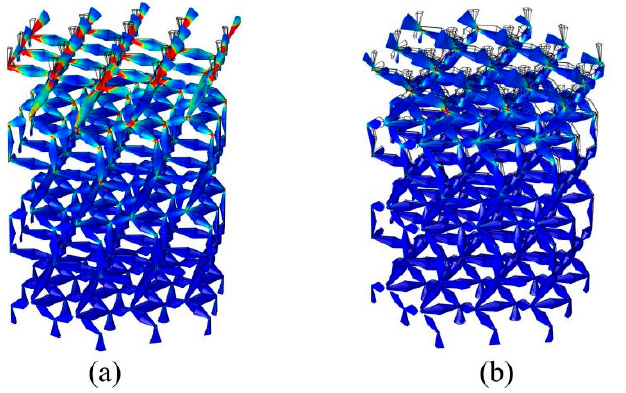
Figure 14. The von Mises stresses of band gap metamaterials on harmonic loads in ( a ) horizontal direction ( b ) vertical direction.